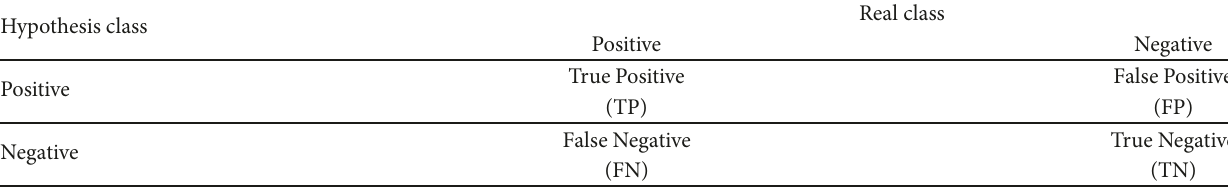
Table 7: Contingency matrix of prediction